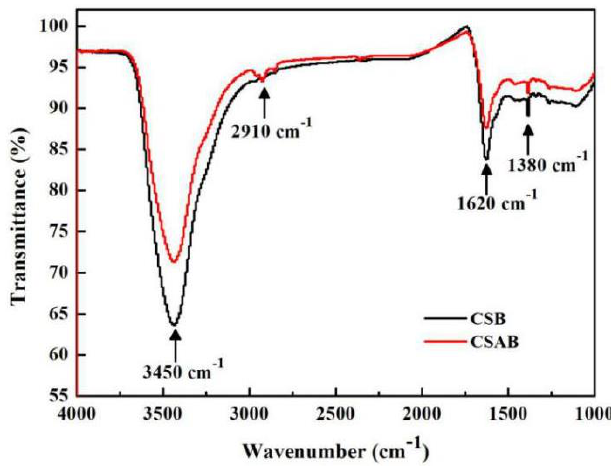
Figure 3. FTIR spectra of CSB and CSAB.